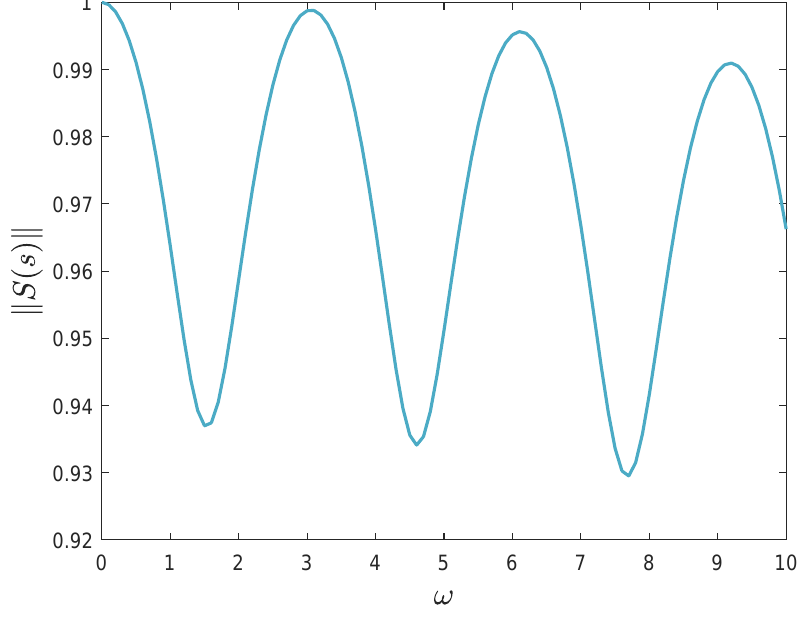
Figure 8. The simulation result of the scattering matrix